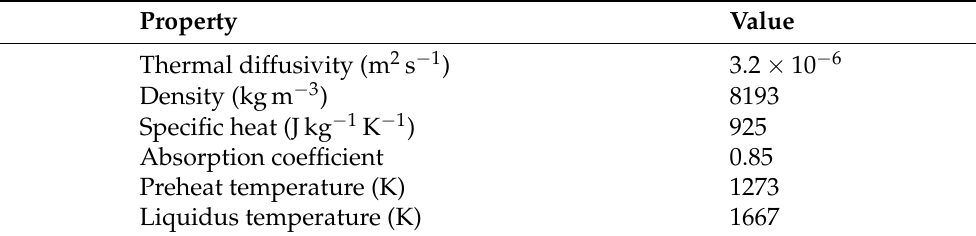
Table 1. Material Properties for CMSX4.